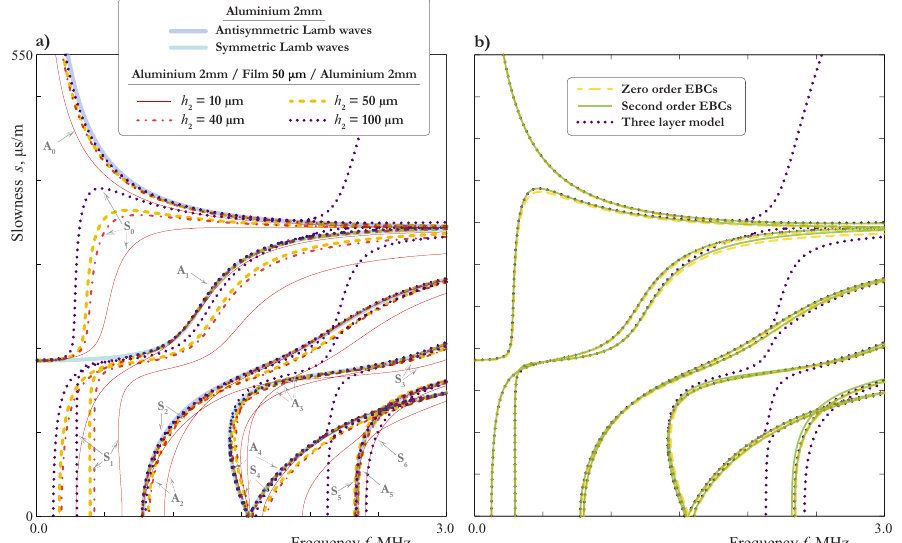
Figure 8. SCs of LWs propagating in the laminate (2 mm aluminium/ h 2 thickness film/2 mm aluminium) at h 2 = 10,40,50,100 µ m ( a ) and in 4.1 mm thickness plate ( h 2 = 100 µ m) calculated using EBCs (21) and (22) of zero order (thin dashed lines), second order (solid lines), three layer model (thick dashed lines) ( b